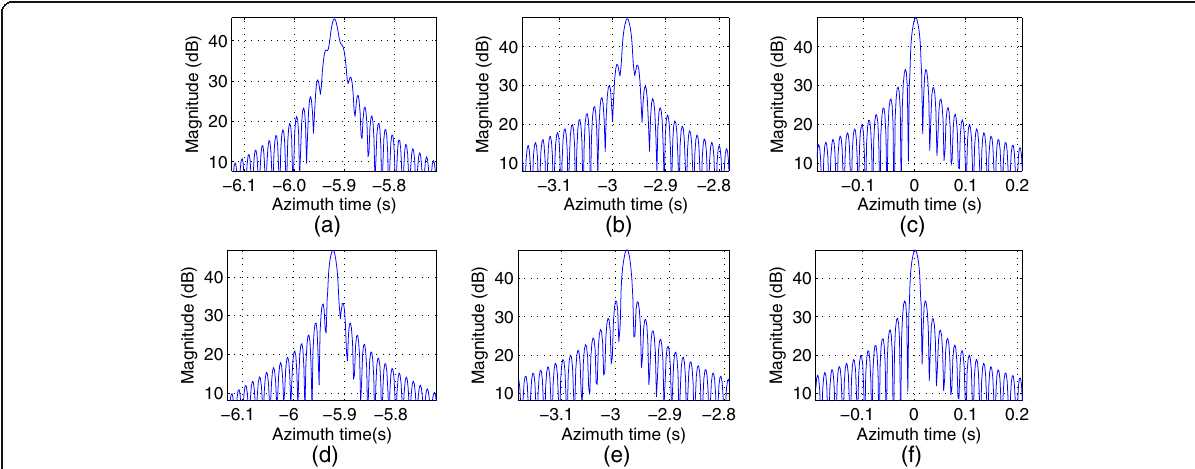
Fig. 16 Azimuth profiles of the three targets by different algorithms in case II. a P 2 , b P 1 , and c P 0 by traditional algorithm in [20]. d P 2 , e P 1 , and f P 0 by the proposed algorithm in this paper